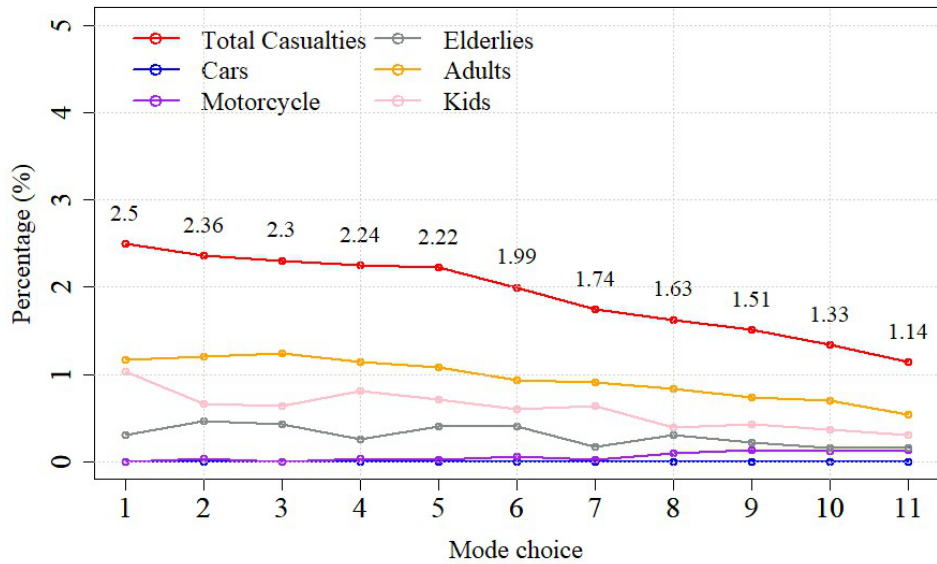
Figure 4. Total deaths (%) depending on the transportation mode choice as in Table